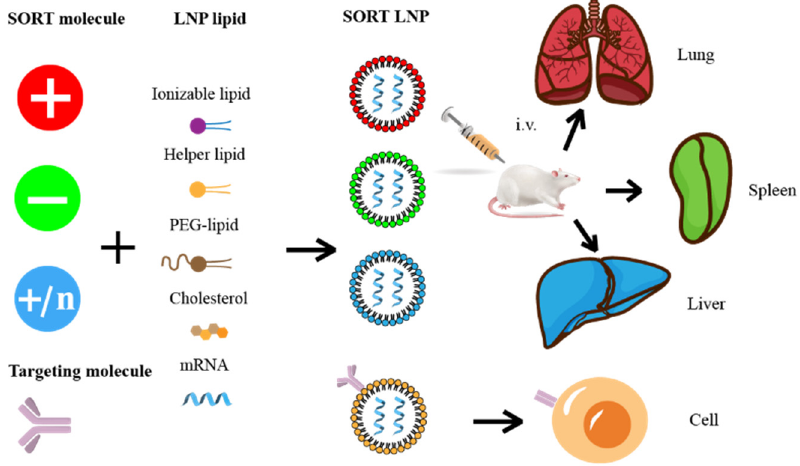
Figure 7. Delivery strategies for various ionized lipids and ligands.